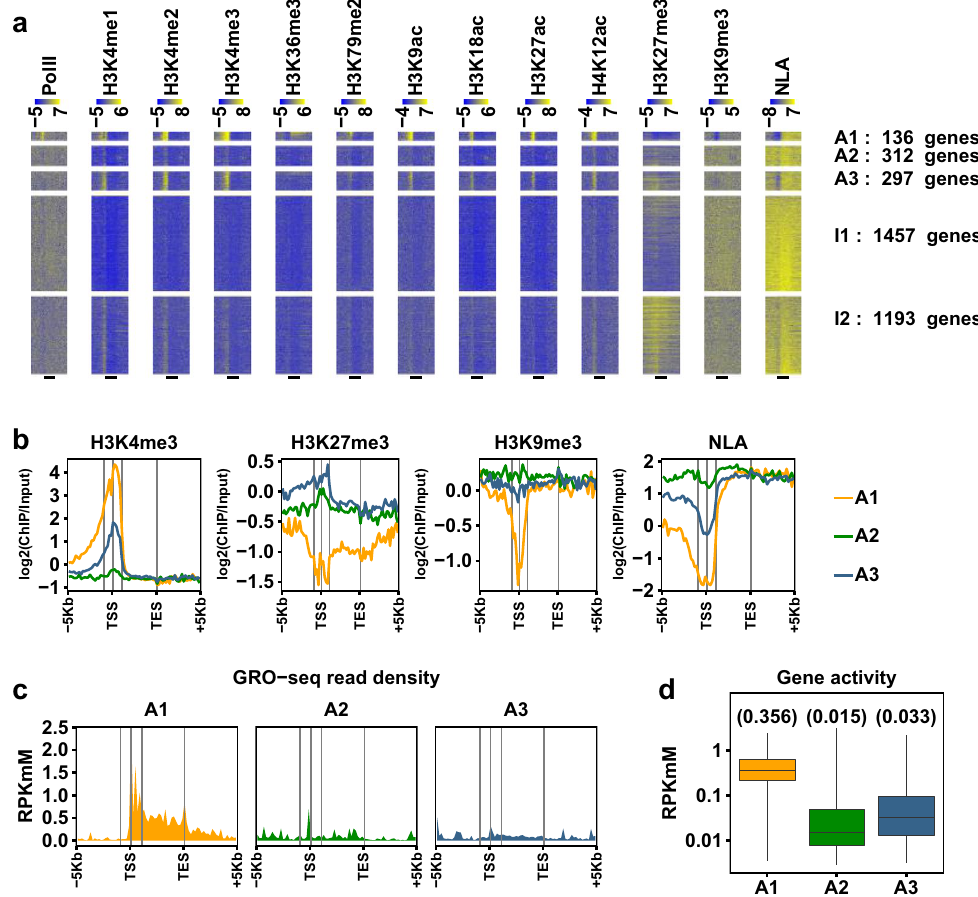
Figure 7. NL genes are differentially enriched with heterochromatic histone marks. ( a ) Heat maps displaying levels of Pol II, histone marks and NLA across genic regions among three groups (A1-A3) of active NL genes and two groups (I1-I2) of inactive NL genes. Genes in A1-A3 groups are sorted by decreasing gene activity and in I1-I2 by increasing gene body NLA. Black bars at the bottom mark annotated transcribed regions from TSS to TES. ( b , c ) Plotting average levels of selected histone marks and NLA ( b ) or average GRO-seq read density ( c ) along genic regions of A1-A3 gene groups, respectively. In a-c, data are binned as described in Fig. 3b. ( d ) Box plot comparing gene activities among A1-A3 gene groups. The minimum and the maximum values are presented by whisker ends and the quartiles by box boundaries. The median values are shown in NL gene subgroups are differentially enriched with heterochromatic histone marks. Several studies have reported that Lamin B1-interacting genomic regions largely overlap with heterochromatin 4, 8, 30 . To examine differential distributions of active and repressive histone modifications among NL genes, we clustered active NL genes into three groups (A1-A3) and inactive NL genes into two groups (I1-I2), respectively (Fig. 7a, Supplementary Fig. S7, Supplementary Tables S1 and S7). A1 group (18.3% of active NL genes) has the highest gene activities (Fig. 7c,d) and the highest levels of active histone marks at promoter regions, and in general is not enriched with H3K27me3 or H3K9me3 (Fig. 7b, Supplementary Fig. S7, Supplementary Table S7). Genome browser views of NLA and epigenetic features of three A1 genes ( Shcbp1 , Caprin2 and Sp4 ) are provided in Fig. 3a and Supplementary Fig. S2. A2 and A3 genes are similar in group sizes (41.9% and 39.9% of active NL genes, respectively), display gene activities that are at least one order of magnitude lower than A1 (Fig. 7c,d) and are slightly enriched (less than 1.2-fold) with H3K9me3 across genic regions (Fig. 7b, Supplementary Fig. S7, Supplementary Table S7). Interestingly, A3 genes have higher levels of both H3K27me3 and active histone marks in promoter regions as well as higher gene activities than A2 genes (Fig. 7b,d, Supplementary Fig. S7, Supplementary Table S7). A1, A2 and A3 groups also differ in the fraction of paused genes (87.2%, 36.5% and 51.3% respectively; p-values < 0.0002 from pairwise comparison by Fisher’s exact test) and PIs among paused genes (median of 14.4, 22.4 and 16.1, respectively; p-values < 0.01 from pairwise comparison by Mann-Whitney test). Among inactive NL genes, both I1 and I2 genes are enriched with H3K9me3 (slightly higher in I1) and I2 genes are more strongly enriched with H3K27me3 (Fig. 7a, Supplementary Figs S7 and S8, Supplementary Table S7). Genome browser views of NLA and epigenetic features of one A2 gene ( Trdn ), one A3 gene ( Pawr ), one I1 gene ( Foxp2 ) and one I2 gene ( Tbx5 ) are provided in Supplementary Fig. S8. Therefore, a subset of both active